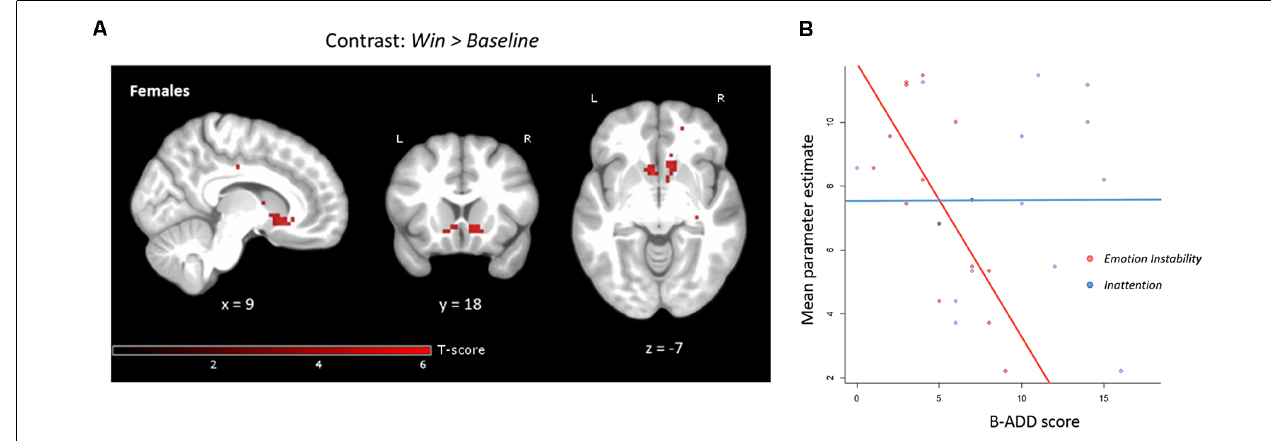
FIGURE 5 | (A) Negative correlation with Emotion Instability , controlling for Inattention in anticipation Win vs. Baseline for females only ( n = 15). Both the right and left VS clusters were significant when applying small volume correction (within the bilateral pre-defined VS ROI). Note that no mask is applied in the above figure for clarity, uncorrected level, p < 0.001. (B) Mean parameter estimates extracted from the pre-defined bilateral VS ROI during reward anticipation correlated negatively with Emotion Instability ( r = − 0.71, p < 0.01, when controlling for Inattention : standardized beta-weight = 0.73, p < 0.01). There was no significant correlation of mean parameter estimates extracted from bilateral VS and Inattention ( r = 0.006, p = 0.98). The maximum B-ADD score for Emotion Instability was 21 (maximum in the current sample: 9) and for Inattention 27 (maximum in the current sample: